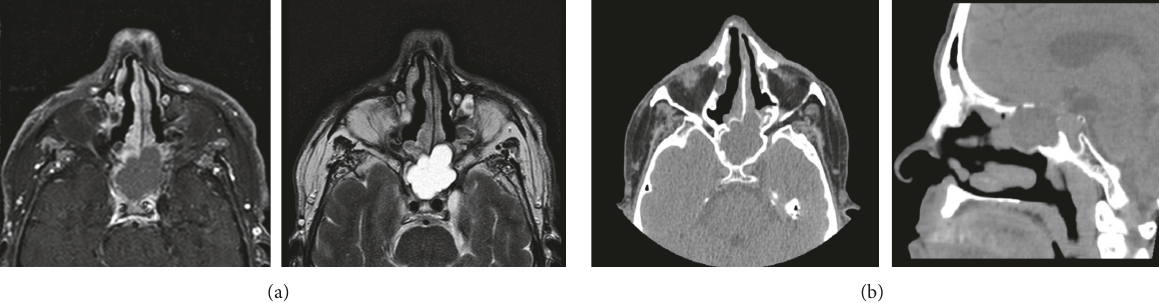
Figure 1: Neuroimaging of the sphenoid sinus mucocele. (a) Paranasal sinus MRI revealing molding of the medial wall of left cavernous sinus by the sphenoid mass. (b) Paranasal sinus CT scan showing sclerosis and interruption of the roof and posterior wall of left sphenoid